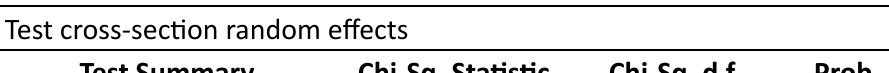
Table 3: Result of the Hausman